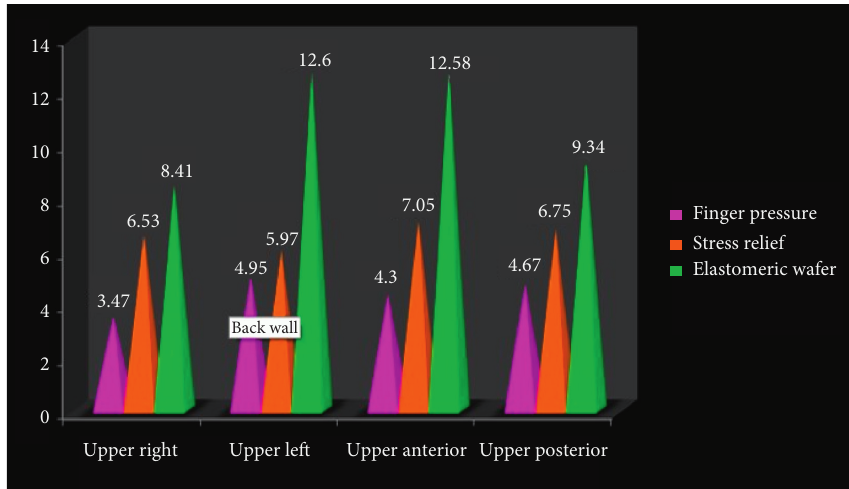
Figure 5: Median score for VAS for upper